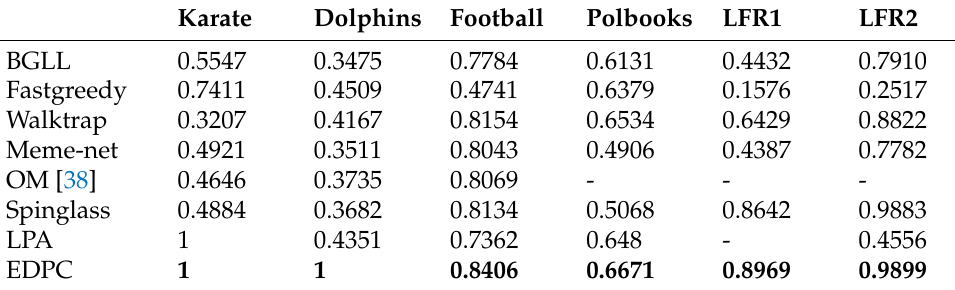
Table 4. Results of ARI on real-world